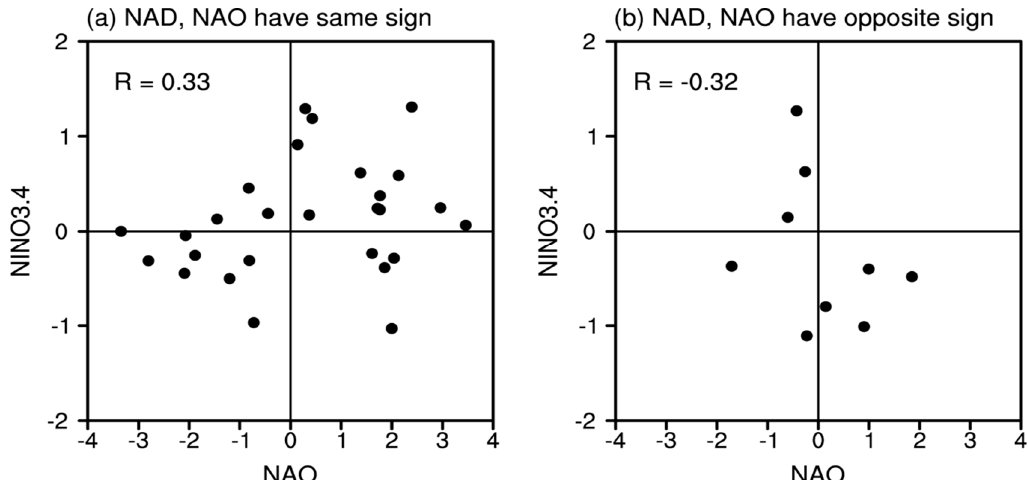
Figure 8. ( a ) Scatterplot of DJFM-averaged NAOI versus the FMAM-averaged Niño3.4 index a year later, plotted only for those years in which the NADI has the same sign as the simultaneous NAOI; ( b ) as (a) but only for those years in which the NADI has the opposite sign as the NAOI. The correlation coefficient ( R ) between the NAOI and Niño3.4 index a year later is given in the upper left corner.